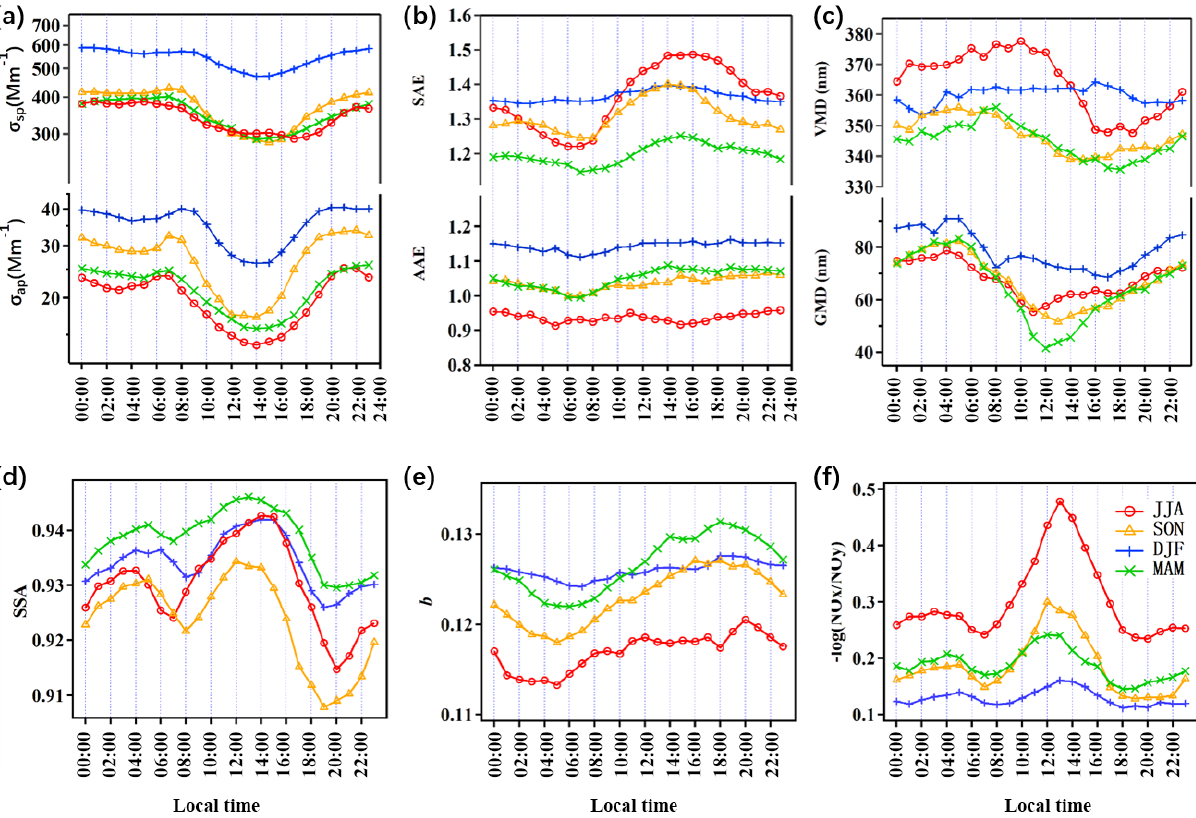
Figure 4. Diurnal variations in (a) scattering coefficient ( σ sp ) at λ = 525nm and absorption coefficient ( σ ap ) at λ = 520nm, (b) Ångström exponents of scattering (SAE) and absorption (AAE), (c) volume mean diameter (VMD) and geometric mean diameter (GMD), (d) single scattering albedo (SSA) at λ = 520nm, (e) backscatter fraction ( b) at λ = 525nm, and (f) photochemical age of air mass ( − log(NO x /NO y ) in the four seasons. The values are the averages of the corresponding hour in the four seasons coded by the colors as green: spring, red: summer, yellow: autumn, blue: